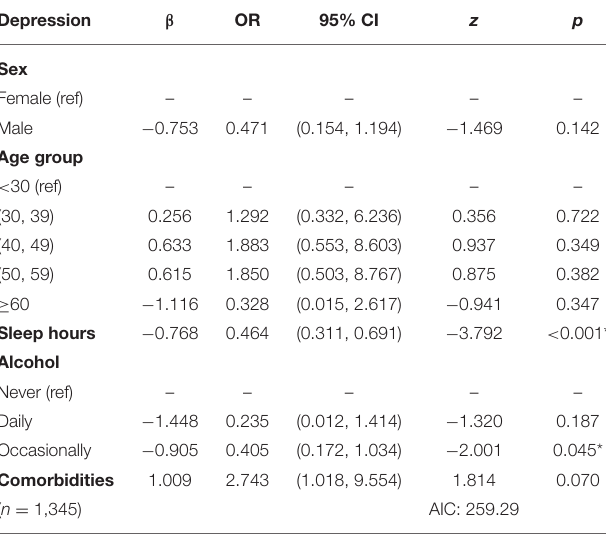
TABLE 5 | Logistic regression analysis to identify factors associated with the presence of depression symptoms in NOVA employees. Depression